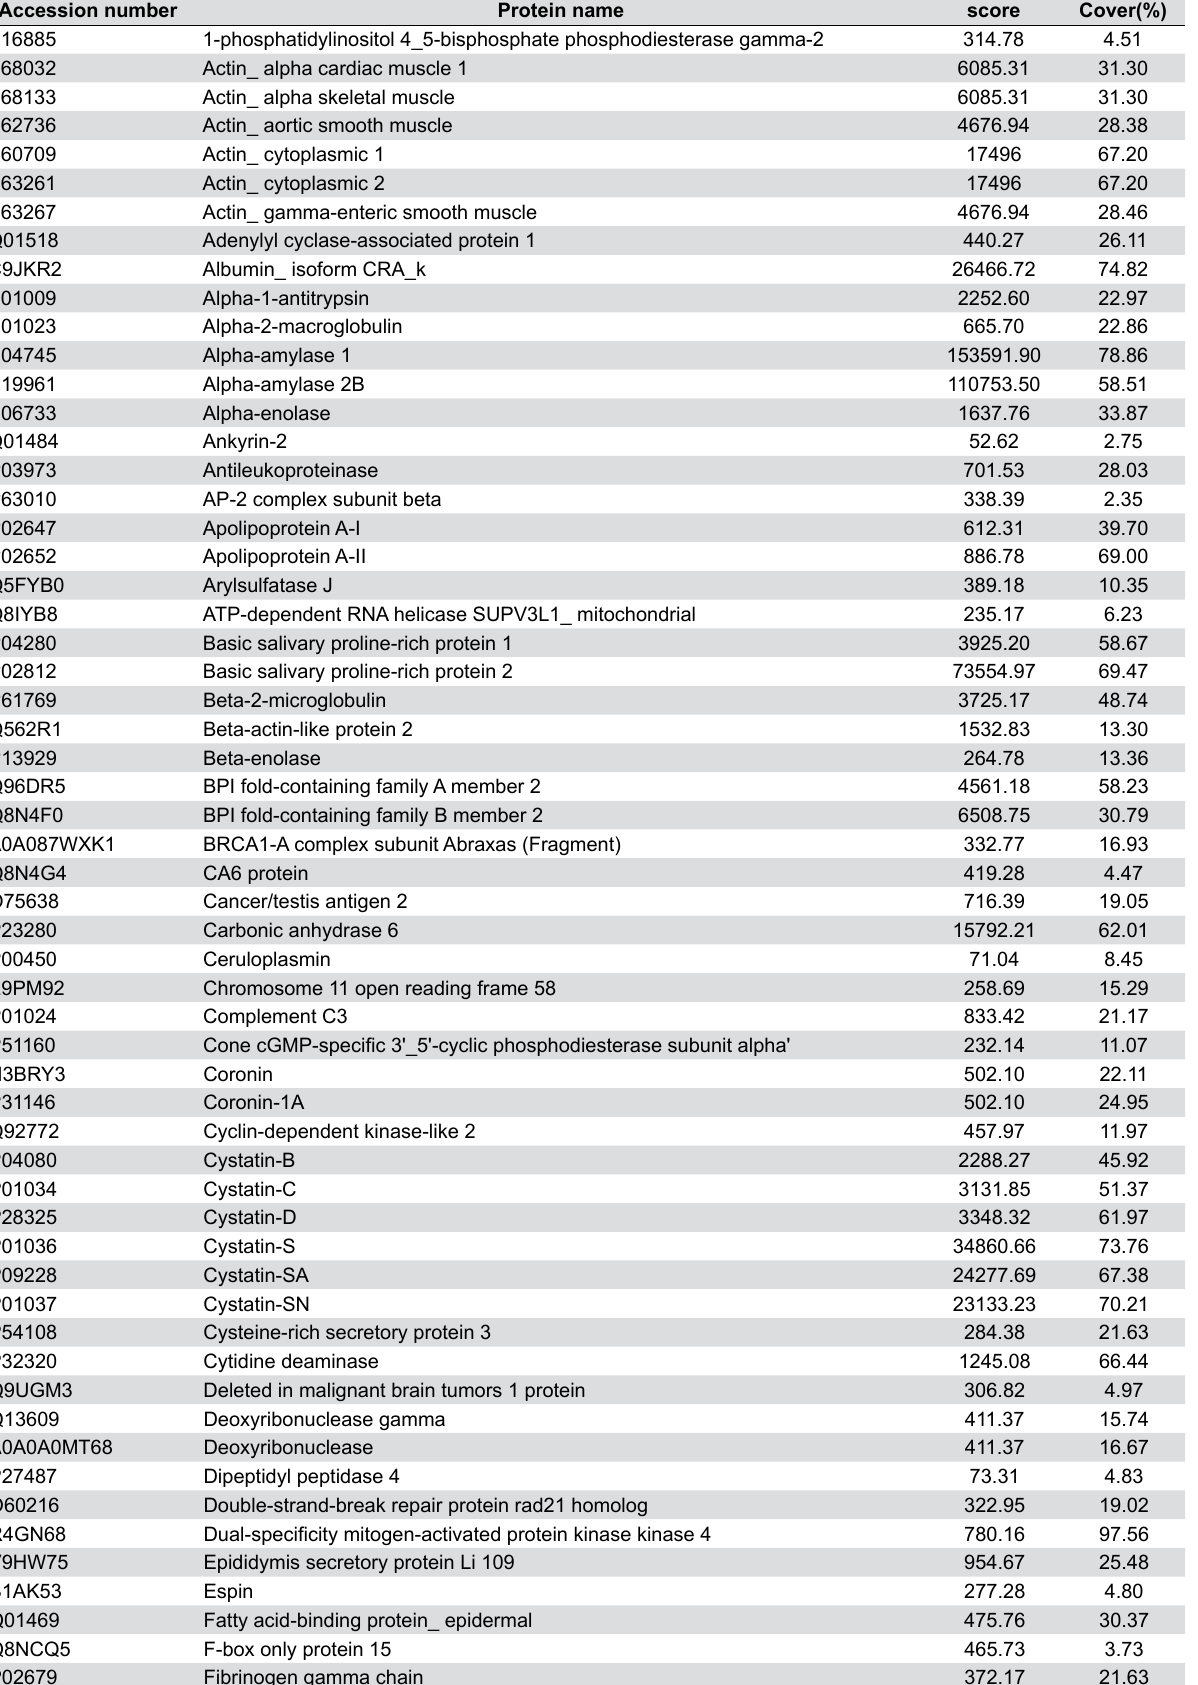
Table 3- Proteins of the saliva identified in the pool